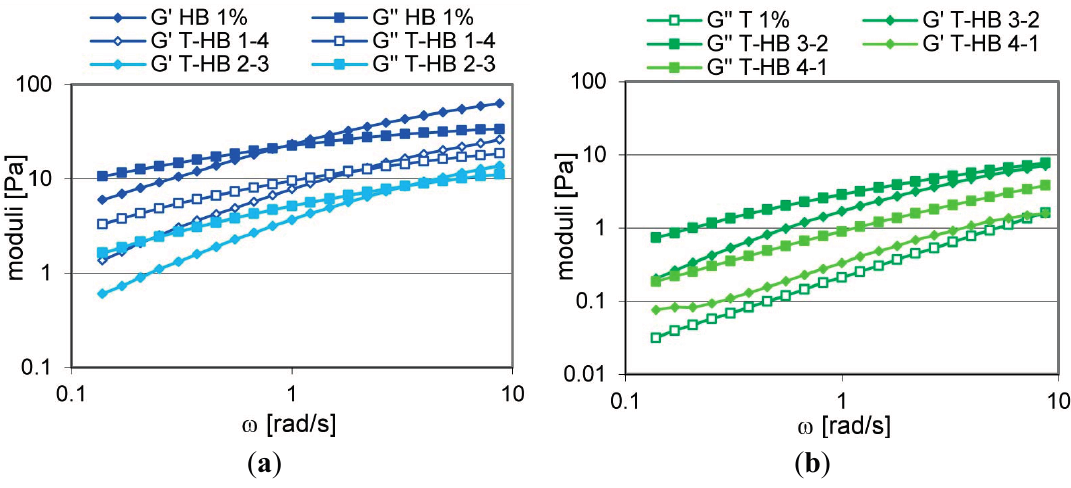
Figure 5. G’ and G’’ trends as a function of the frequency of TSP-HB mixtures in different ratios: ( a ) 0:1, 1:4, 2:3; ( b ) 1:0, 3:2, 4:1 (1% w / w